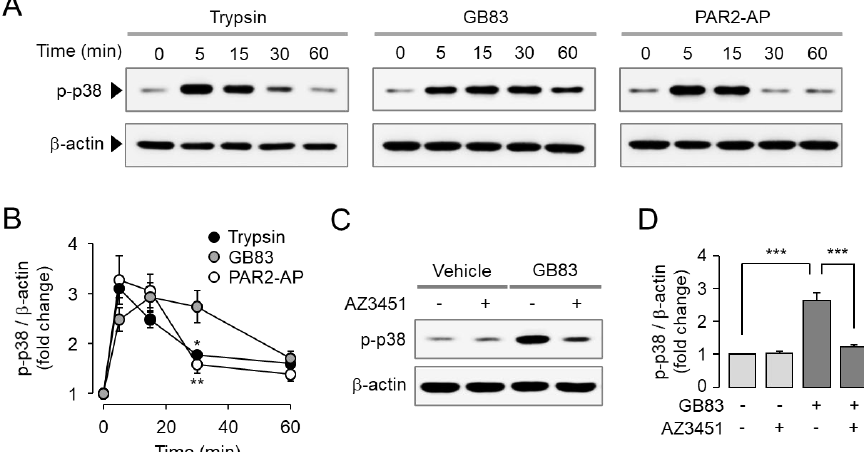
Figure 4. GB83 induced phosphorylation of p38 MAPK through PAR2 activation in HT-29 cells. ( A ) Representative immunoblots of p38 phosphorylation. PAR2 stimulated by trypsin (30 U/mL), GB83